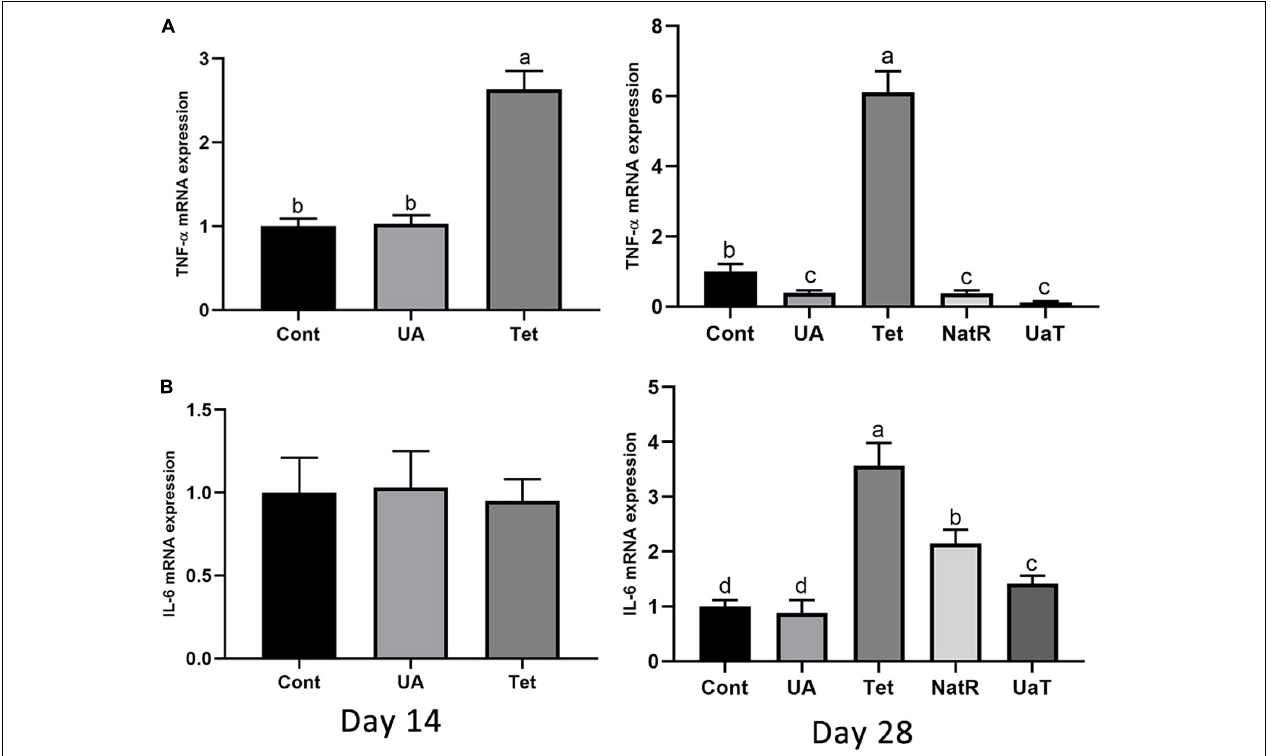
FIGURE 5 | Effects of administration of ursolic acid on the expression of mRNAs corresponding to TNF- α (A) and IL-6 (B) in colon tissue of mice. All group names correspond to those described in the legend of Figure 2 . Data are shown as means ± standard deviations. Statistically significance results between each treatment group on days 14 and 28 were expressed by lowercase letters (a, b, c) based on ANOVA with Duncan’s range tests. Mean values with different letters indicate statistically significance results ( P < 0.05). n = 6 mice per group.